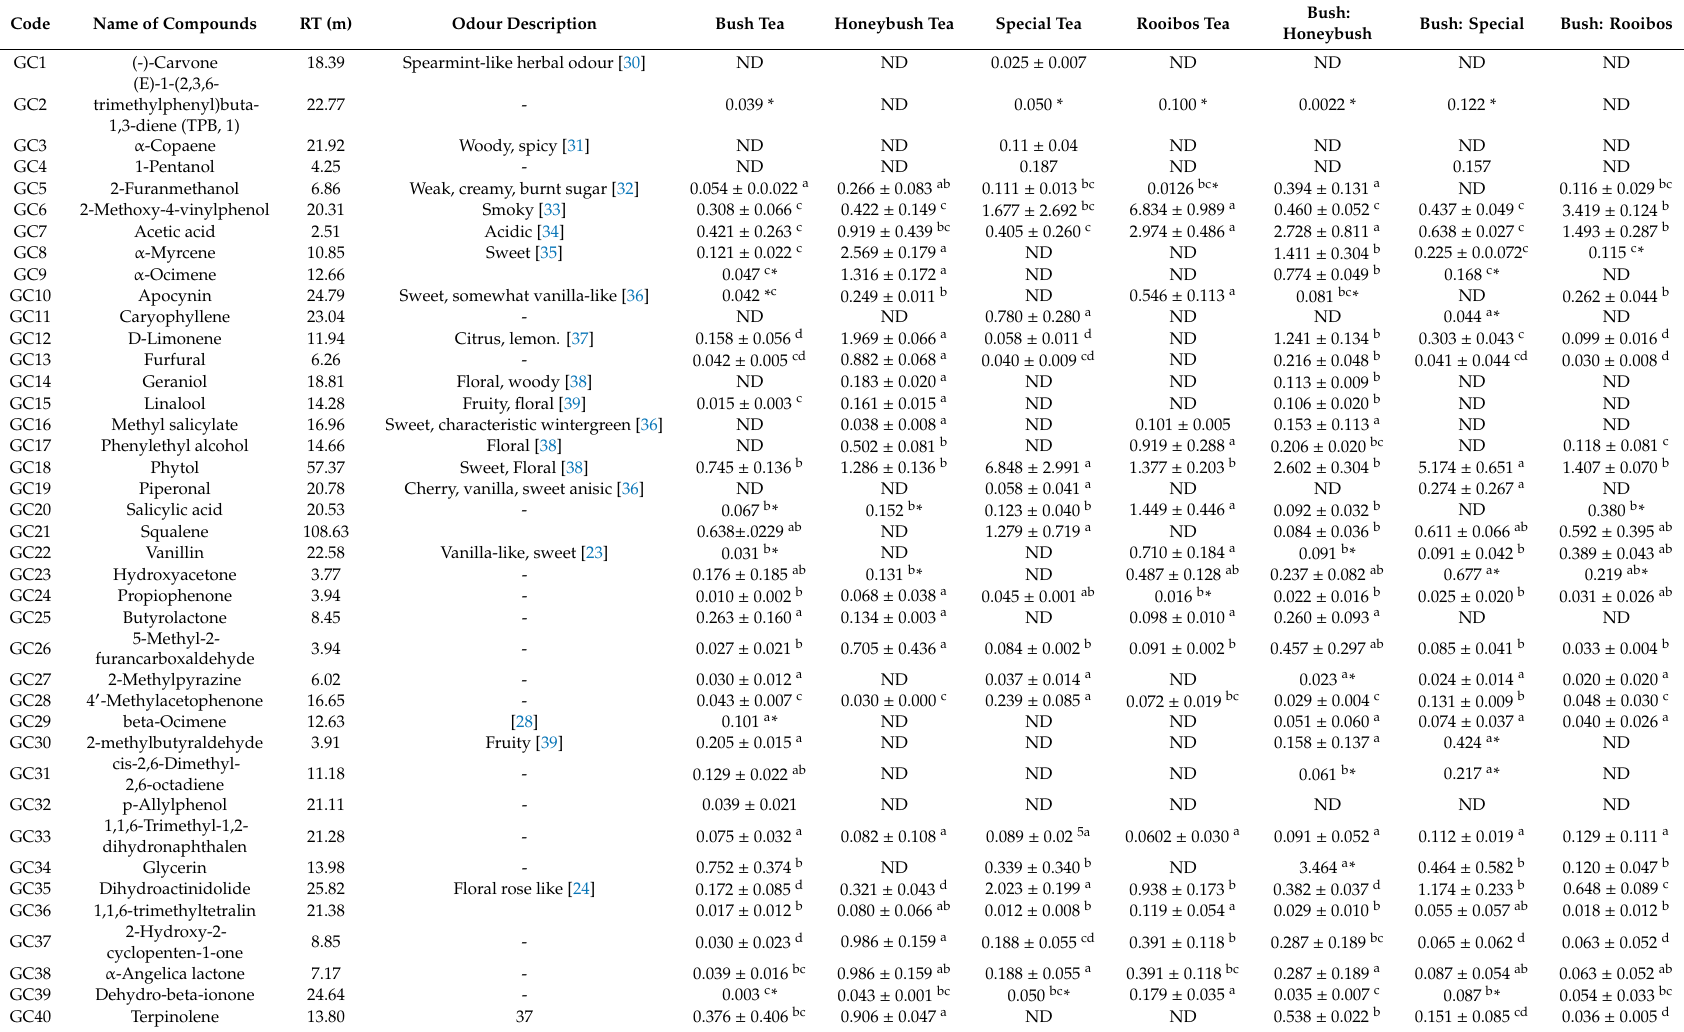
Table 3. Compounds detected and concentrations using a gas chromatography-mass spectrometer (GC-MS) in seven tea samples.